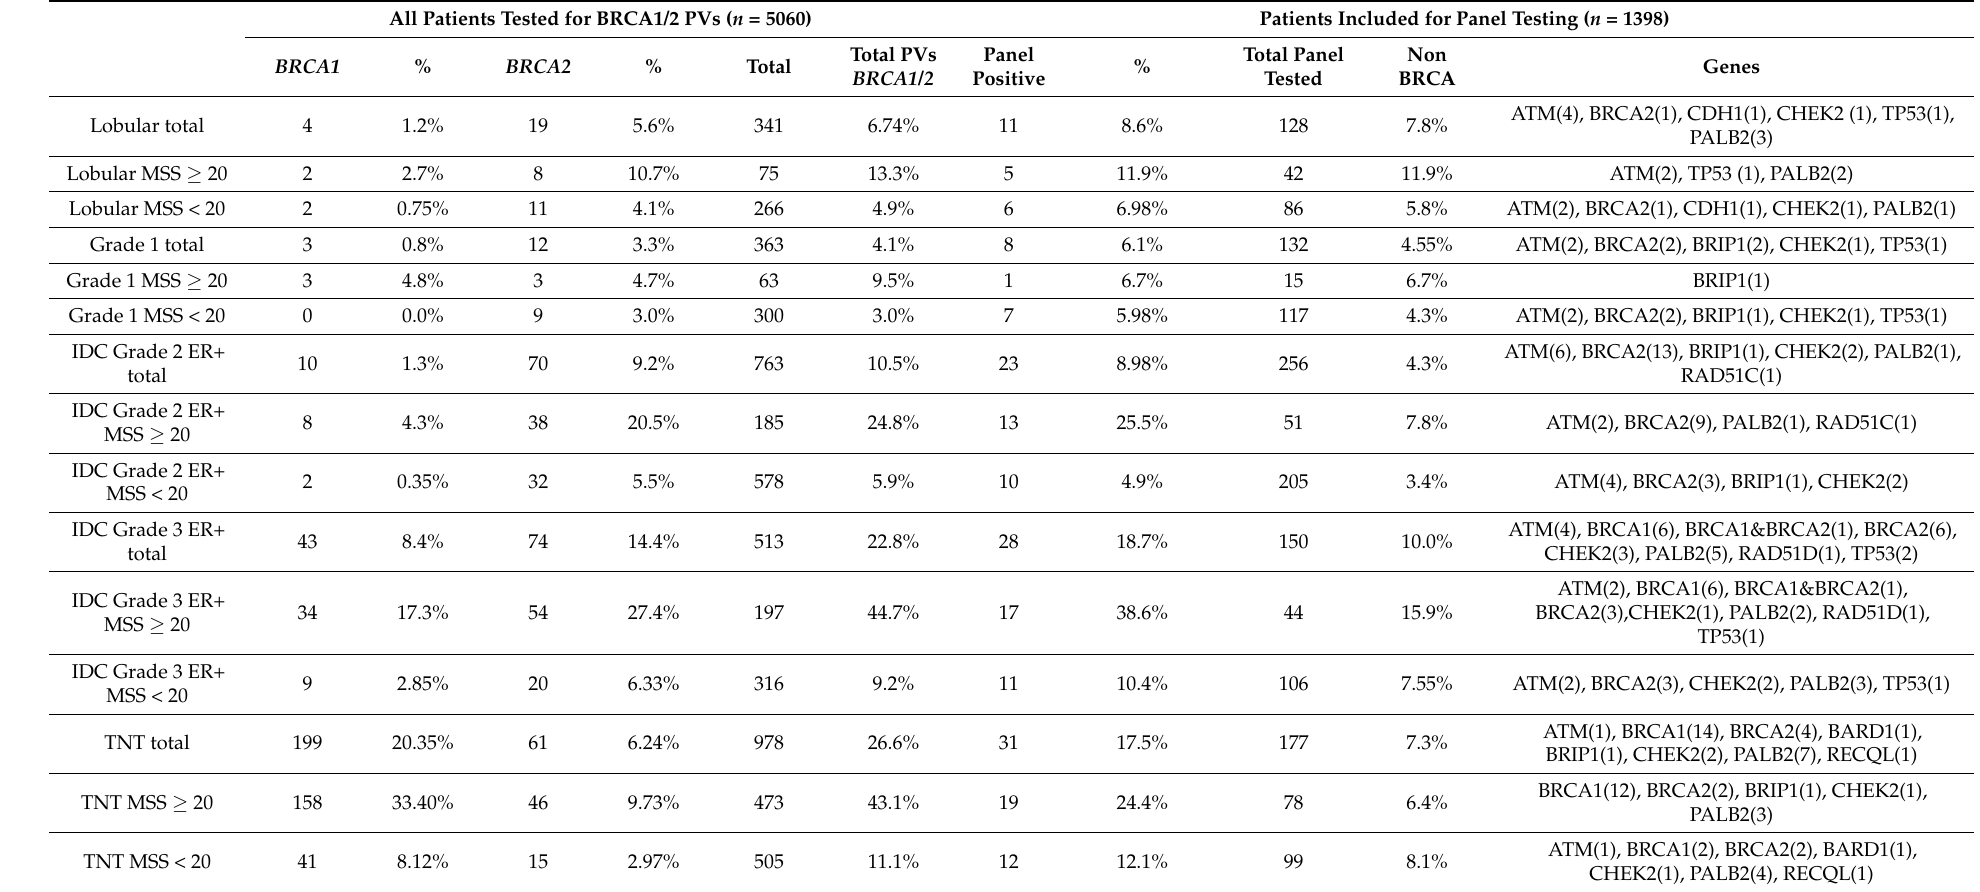
Table 2. Rate of PVs by pathology and Manchester